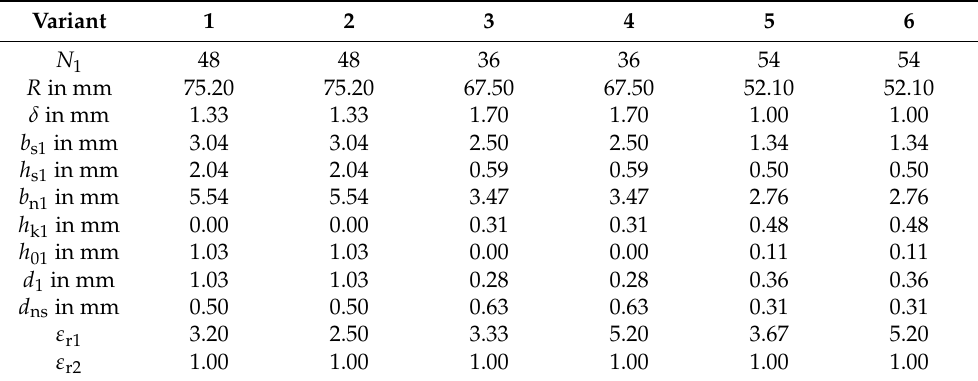
Table 1. Geometric and material properties of the investigated stator slot